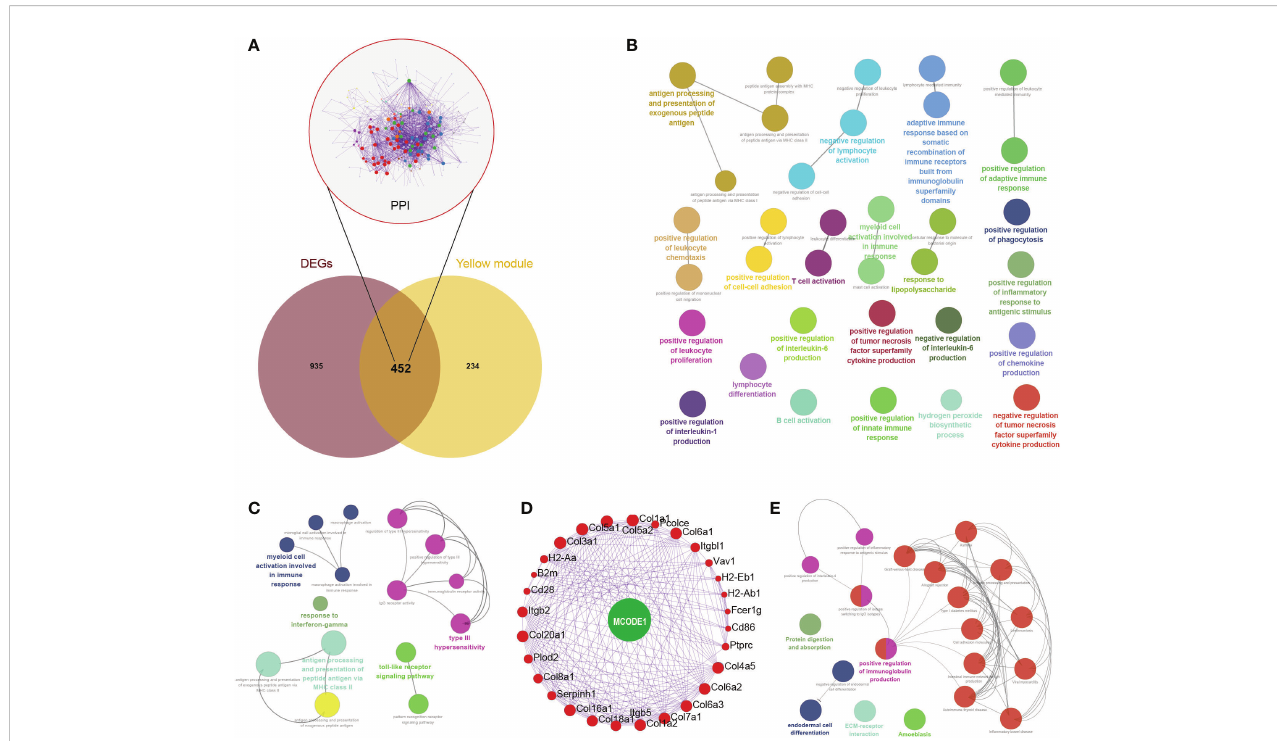
FIGURE 4 Comprehensive analysis of key regulatory genes. (A) Venn diagram of intersected genes between differentially expressed genes (DEGs) and yellow module genes. Protein-protein interaction network of 452 key regulatory genes were also displayed. (B) Biological pathways of these 452 key regulatory genes. (C) Immune pathway of key regulatory genes. (D) Hub genes were selected in the protein – protein interaction through the MCODE application. (E) Biological pathways of these 29 hub genes.